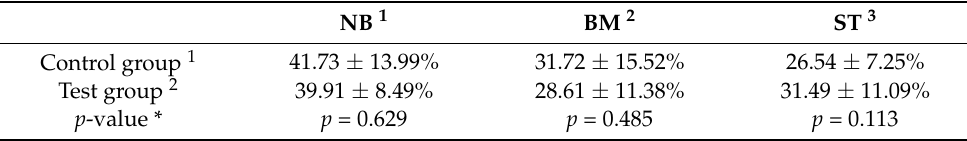
Table 3. Comparison of the tested and control groups according to variables, expressed as percentages.